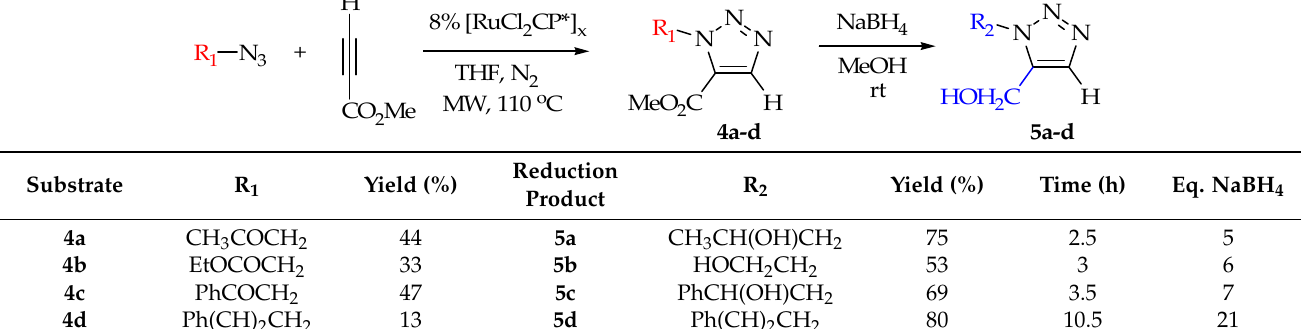
Table 2. Preparation of methyl 1-substituted-1 H 1,2,3-triazole-5-carboxylates using dichloro(pentamethylcyclopentadienyl)ruthenium polymer (RuCl 2 CP*) x catalyst and their reduction by NaBH 4 .